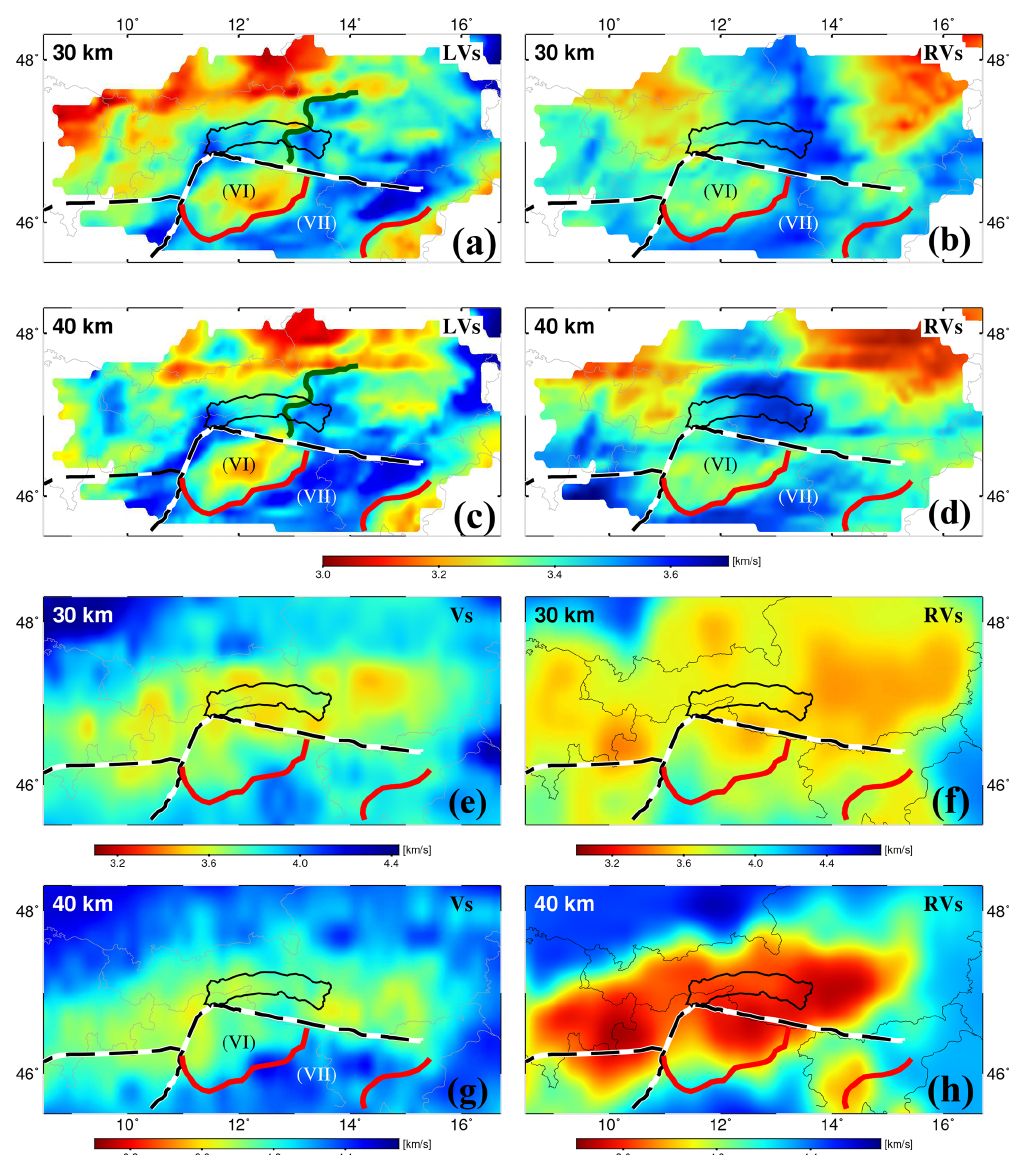
Figure 13. (a, c) Depth slices of the Love-wave shear velocity model (LVs). (b, d) The Rayleigh-wave Vs model (RVs) presented in this study. The red lines outline the high-velocity anomaly to the south of the Periadriatic line (PAL) marked by VII. Periadriatic and Giudicarie faults are shown as black and white lines labeled PL and GU in Fig. 1. The western margin of high velocity to the north of the PAL is marked by the dark green line. (e, g) Depth slices of the Vs model of Kästle et al. (2018) at 30 and 40km of depth, respectively. (f, h) Depth slices of the RVs model of Lu et al. (2018) at 30 and 40km of depth. The high-velocity anomaly marked VII in our Vs models can also be seen in the Kästle Vs model (e, g) and partly in the RVs of the Lu model (h)